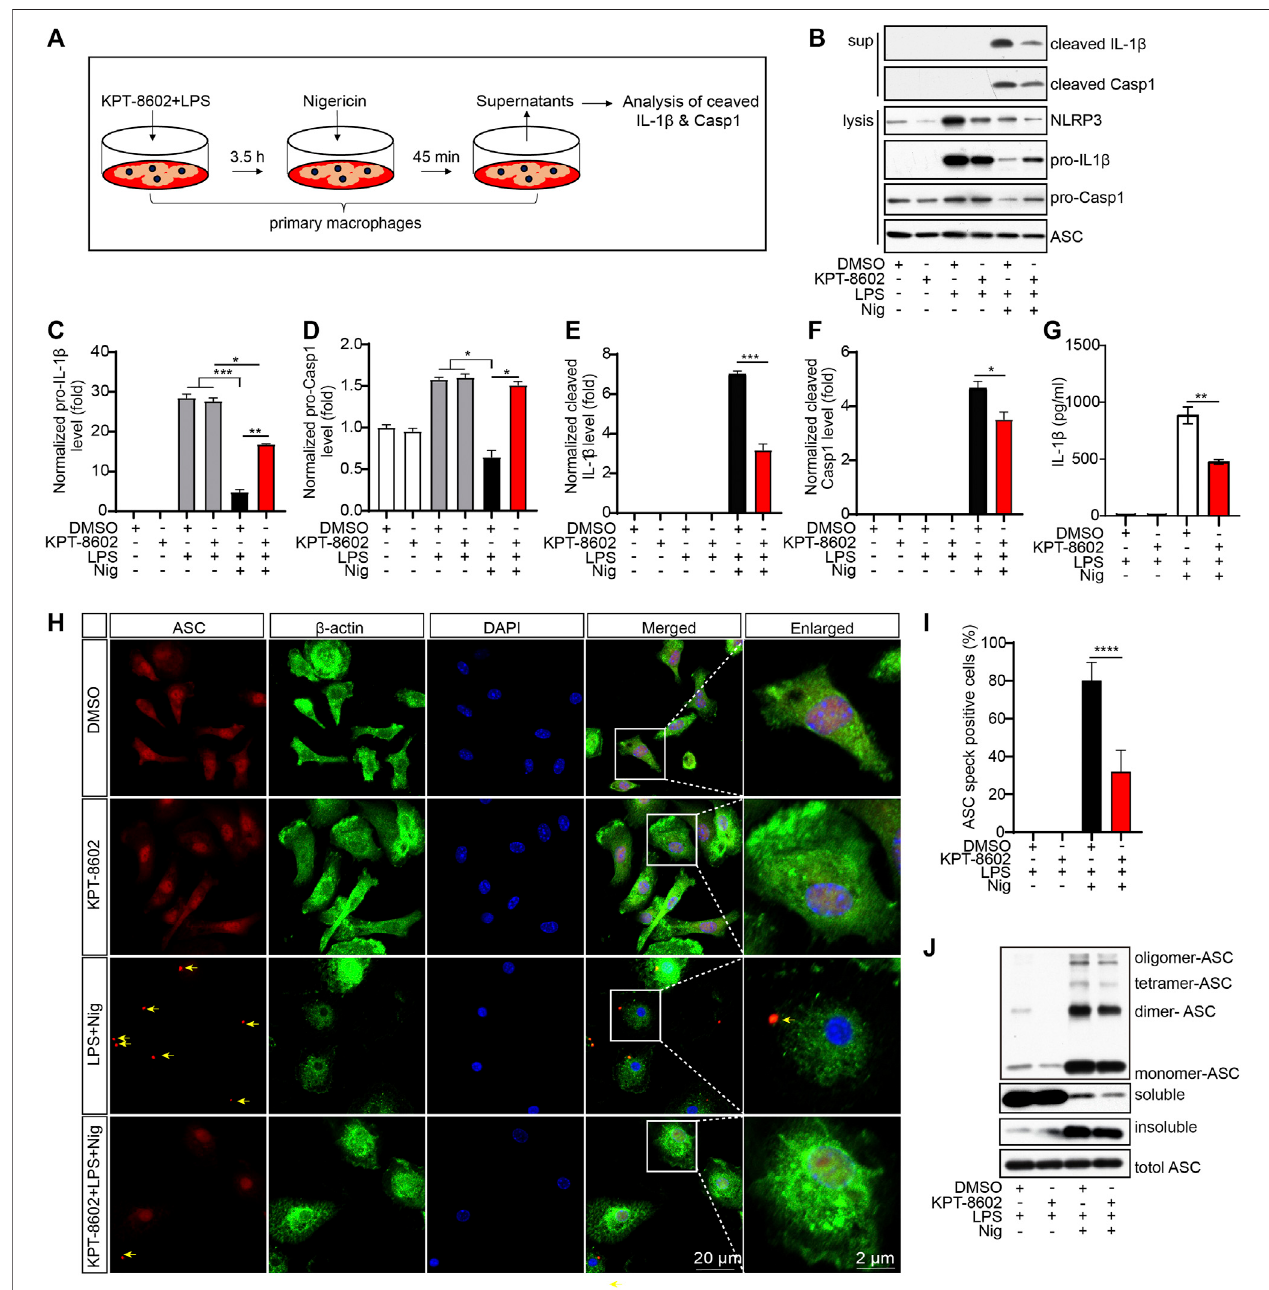
FIGURE 2| KPT-8602 inhibits theactivation and assembly of the NLRP3 in fl ammasome in vitro . (A) Working model of the NLRP3 in fl ammasome activation. (B – F) PMs pretreated with LPS were treated with KPT-8602 for 30 min and nigericin (Nig) for 45 min, and the cells and supernatants were harvested for analysis of the expression ofNLRP3,pro-IL-1 β ,pro-caspase-1, cleaved IL-1 β , cleaved caspase-1, and ASC byWestern blotting (B) .Gray valuesofthepro-IL-1 β (C) ,pro-Casp-1 (D) , cleavedIL-1 β (E) ,andcleavedCasp-1 (F) bandswereanalyzedbyusingImageJandwerenormalizedtoASC. (G) PMspretreatedwithLPSweretreatedwithKPT- 8602 for 30 min and nigericin (Nig) for 45 min, and the cells and supernatants were harvested for analysis of the expression of cleaved IL-1 β by ELISA. (H,I) PMs pretreated with LPS were treated with KPT-8602 for 30 min and nigericin (Nig) for 45 min. Then, the cells were fi xed and stained with a rabbit anti-ASC antibody and mouse anti- β -actin antibody (H) , and the number of cells containing ASC specks (yellow arrows) was analyzed by ImageJ. (I) Scale bars, 20 μ m for low-magni fi cation images and 2 μ m for high-magni fi cation images, respectively. (J) PMs pretreated with LPS were treated with KPT-8602 and Nig for 45 min, and then the cells were harvested and cross-linked with disuccinimidyl suberate (DSS) for analysis of the oligomerization of ASC by Western blotting. (* indicates p < 0.05, ** indicates p < 0.01, *** indicates p < 0.001, **** indicates p < 0.0001 by Student ’ s t test or one-way ANOVA).